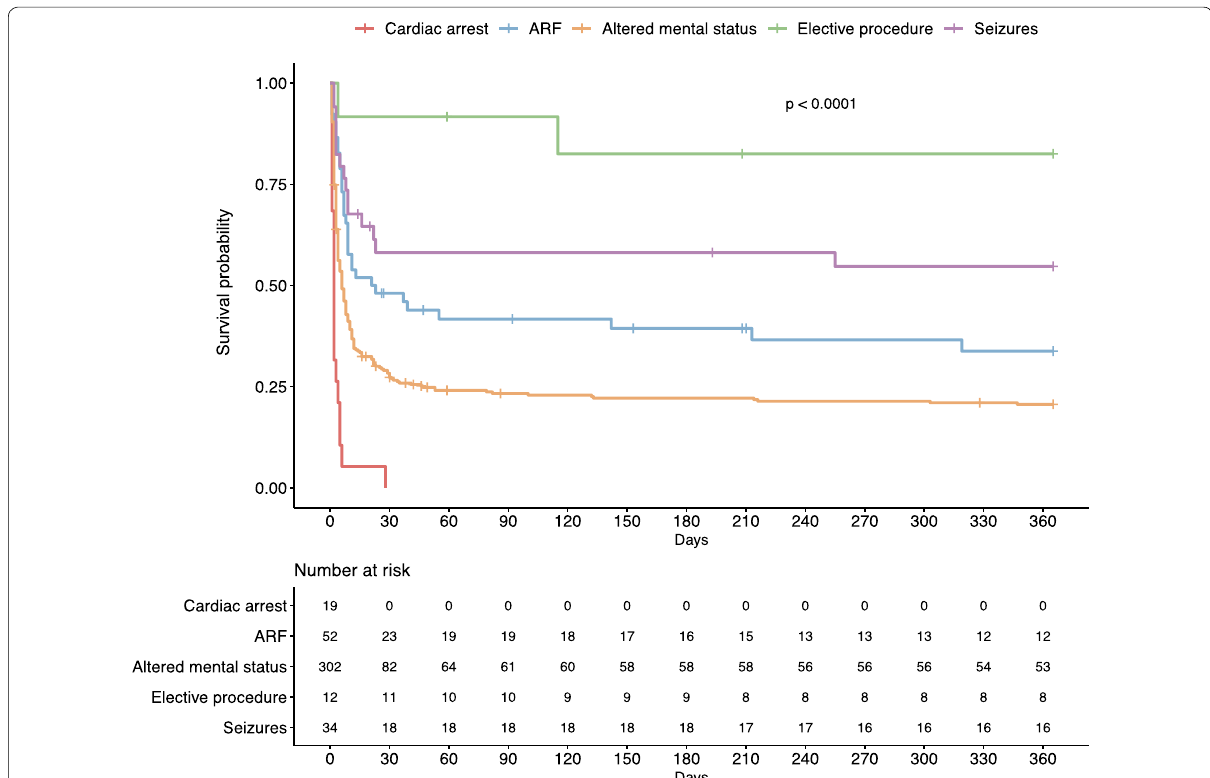
Fig. 1 Kaplan–Meier’s survival estimates of patients according to the reason for endotracheal intubation